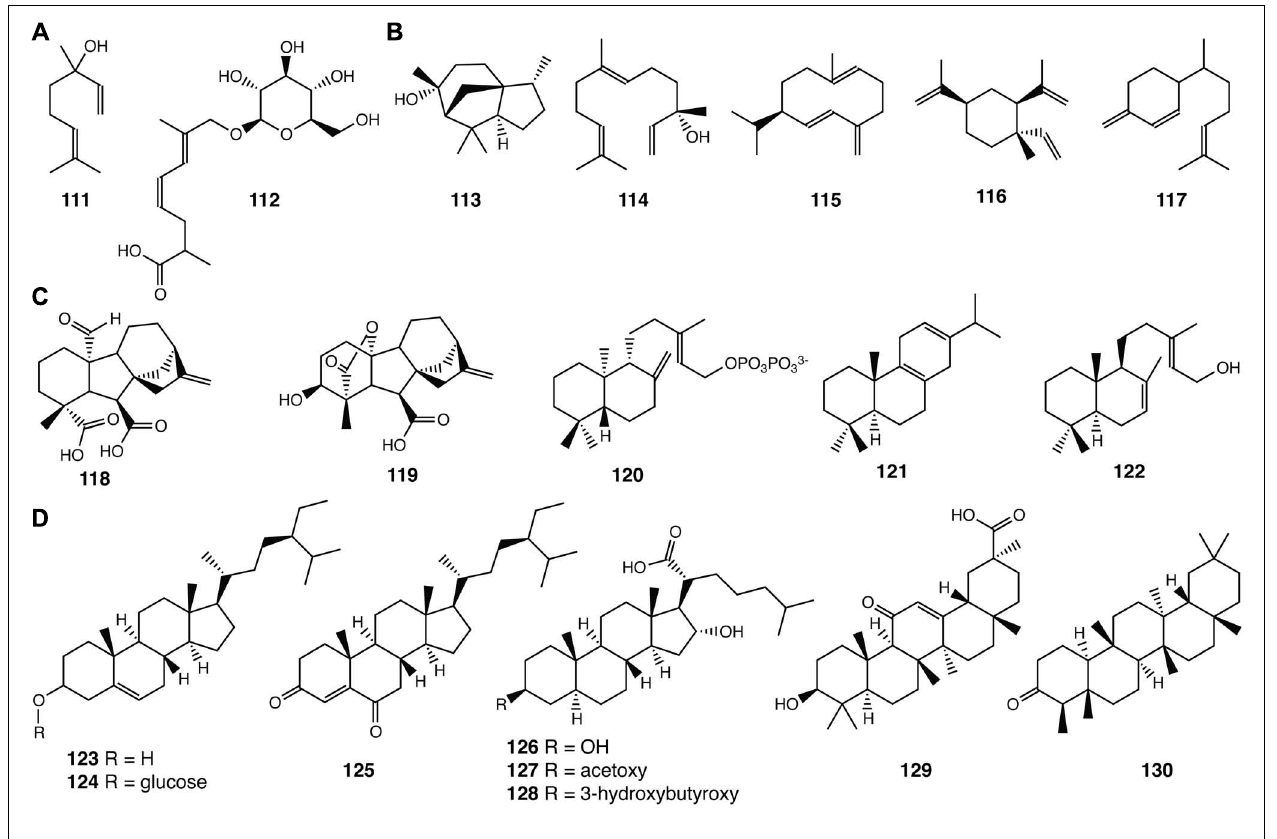
( 122 ). (D) Triterpenes: β -sitosterol ( 123 ), β -daucosterin ( 124 ), pulvinatadione ( 125 ), 3 β ,16 (cid:3) -dihydroxy-5 (cid:3) ,17 β -cholestan-21 -carboxylic acid ( 126 ), 3 β -acetoxy-16 (cid:3) -hydroxy-5 α , 17 β -cholestan- 21-carboxylic acid ( 127 ), 3 β -(3-hydroxybutyroxy)-16 α -hydroxy-5 α , 17 β -cholestan-21-carboxylic acid ( 128 ), glycyrrhetinic acid ( 129 ), friedelin ( 130